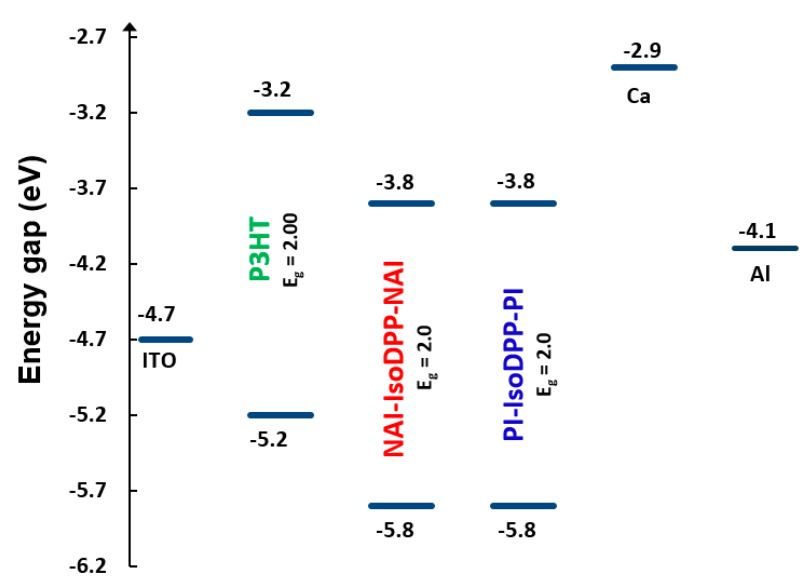
Figure 5. Schematic energy level diagram for NAI-IsoDPP-NAI, PI-IsoDPP-PI, and P3HT [32], and the work functions of the electrodes used in the organic solar cells (OSCs) [8].